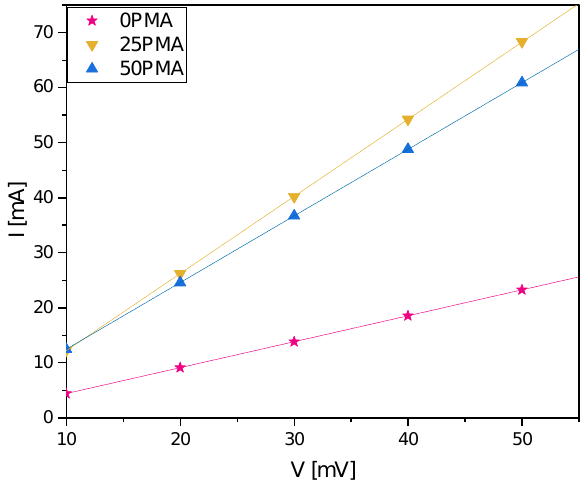
Figure A4. I–V curves resulting from chronoamperometry measurements.